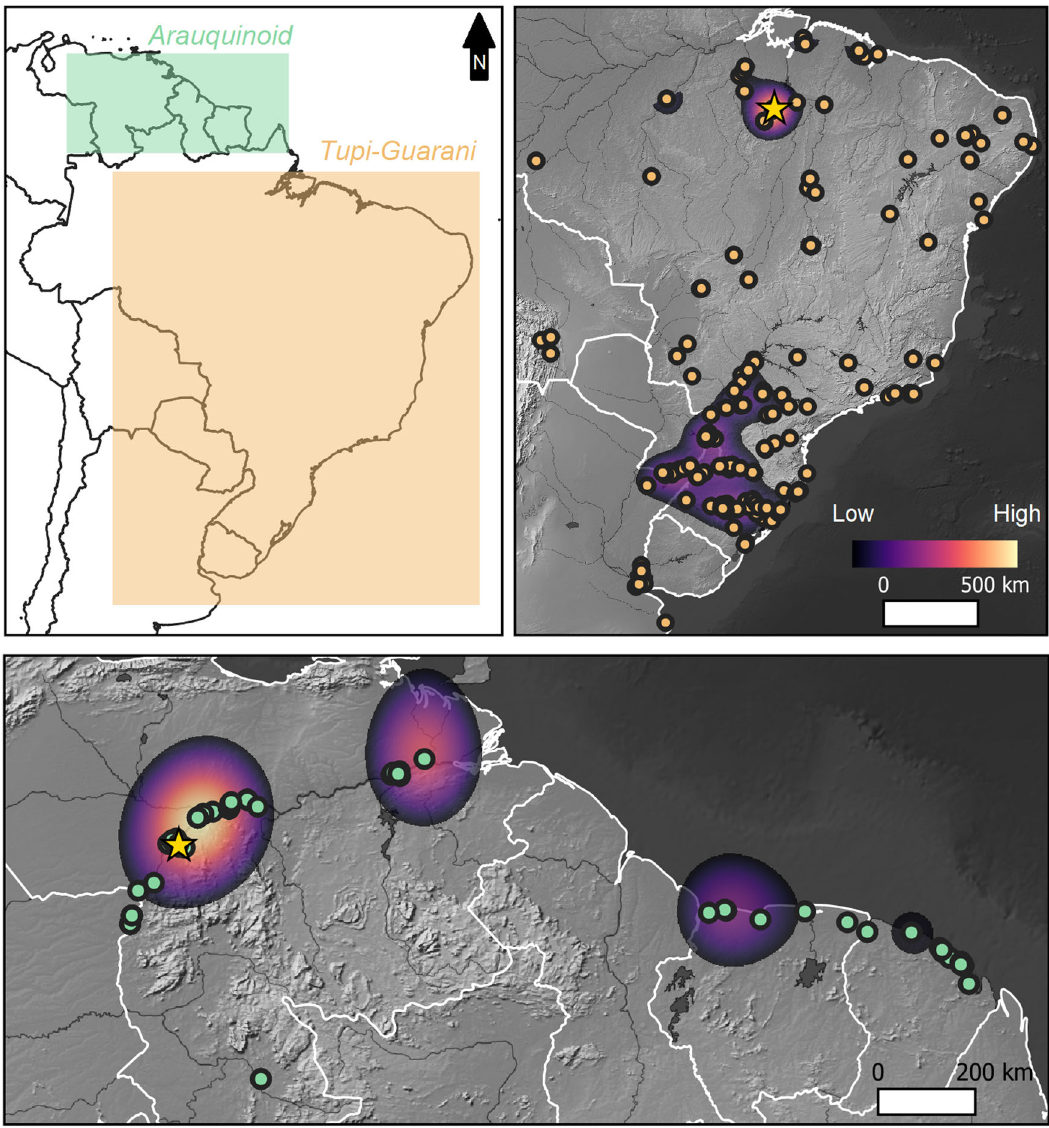
Fig. 1 Domains of the Arauquinoid (green) and Tupiguarani (orange) radiocarbon datasets in South America, with earliest dated sites (yellow stars). Insets show kernel density estimates ( σ = 100 km) of georeferenced radiocarbon dates, illustrating relatively high-density areas, fi ltered with an arbitrary cut-off of one standard deviation above the mean